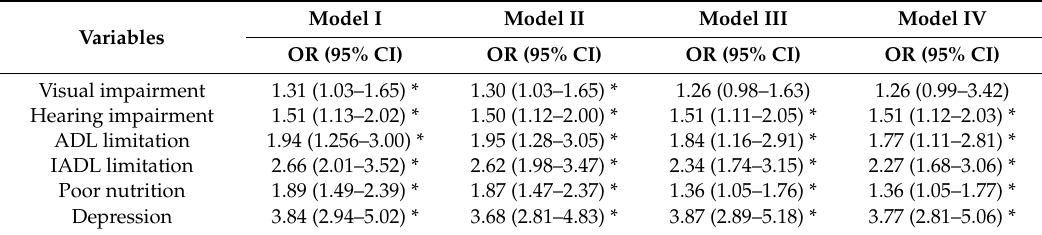
Table 3. Multivariable logistic regression analysis of factors associated with poor self-reported health